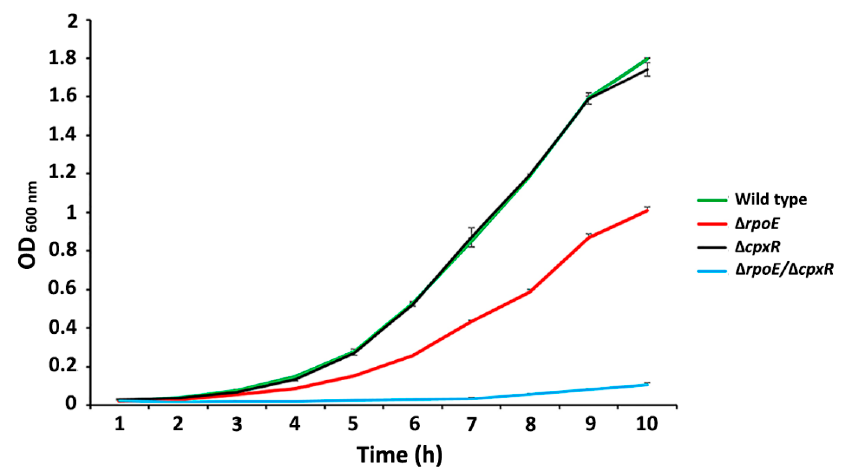
Figure 1. Effect of deletion of the rpoE, cpxR and rpoE/cpxR genes on the growth of S . Enteritidis in Luria–Bertani (LB) broth at 22 °C (room temperature). A significant decrease in growth was seen in Δ rpoE as well as for the Δ rpoE / Δ cpxR strain when compared with the wild type and Δ cpxR strains ( p < 0.001). Error bars represent the standard deviation as determined by t -test in comparison with the wild-type and Δ cpxR strains.